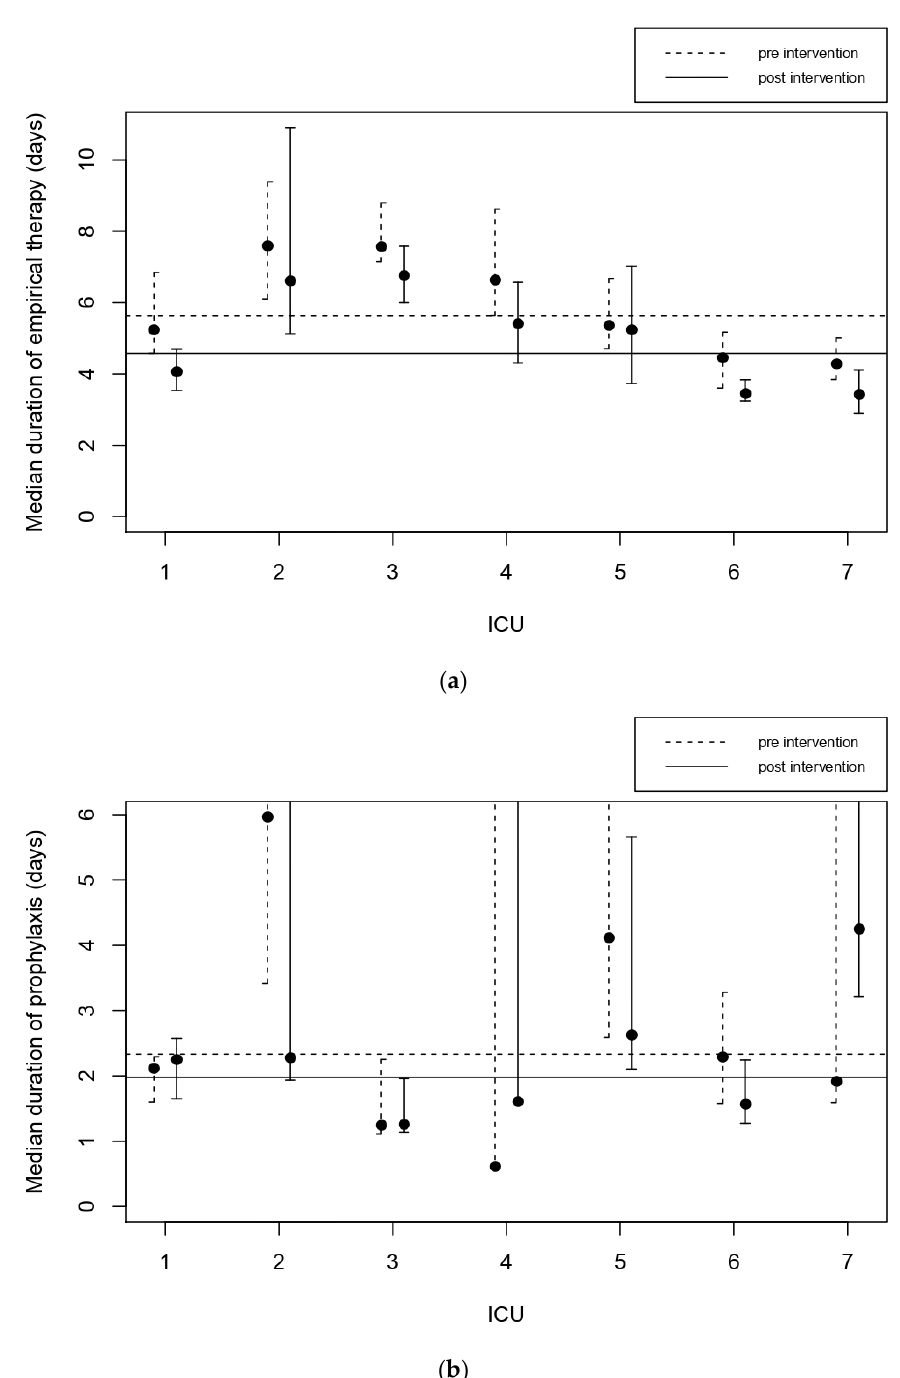
Figure 2. Median duration of empirical therapy ( a ) and prophylaxis ( b ) for the participating centers, pre ‐ (dashed line) and post ‐ intervention (solid line). The horizontal line indicates the average. The use of quinolones more than halved. Before the intervention 15.3% of patients needing antibiotics received quinolones. This decreased to 6.0% after the intervention ( p < 0.001). Quinolones were used for about 10% to 30% of patients in the seven ICUs. Its usage in all the units decreased in both value and variability, ranging from about 3% to 10% (Figure 3a).